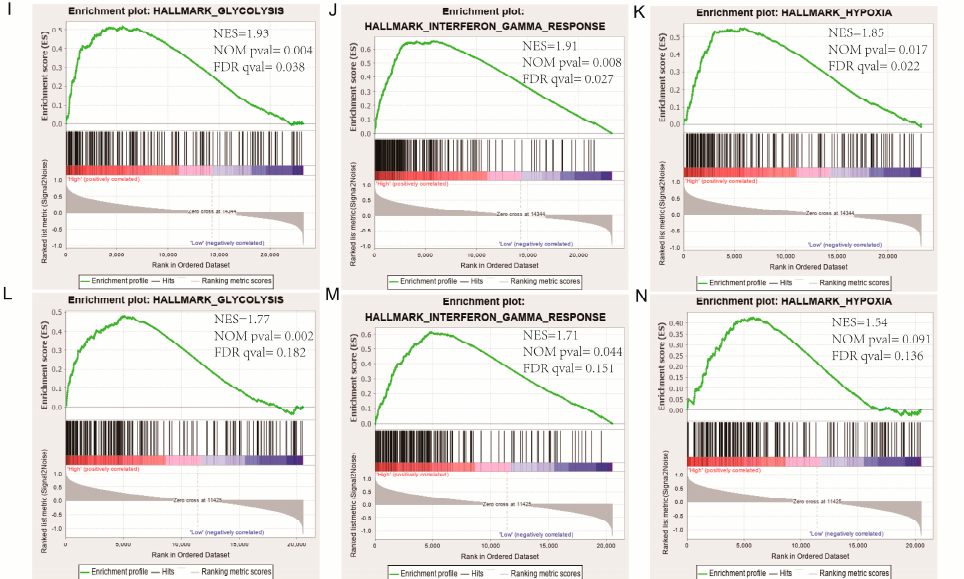
Figure 1. Exploration of biological function. ( A , B ) Volcano plot of gene expression profile data in high-PI12 samples and low-PI12 ones in CGGA and TCGA cohort; ( C , D ) Venn diagram of up-regulated and down-regulated differentially expressed genes (DEGs); ( E , G ) Bubble plots of the top ten GO terms of biological processes based on the up-regulated and down-regulated genes; ( F , H ) Bubble plots of the top ten KEGG pathways based on the up-regulated and down-regulated genes; ( I – K ) Gene set enrichment analysis (GSEA) showed the biological functions and pathways that were significantly enriched in patients with high-PI12 score in CGGA cohort; ( L – N ) The biological functions and pathways that were significantly enriched in TCGA